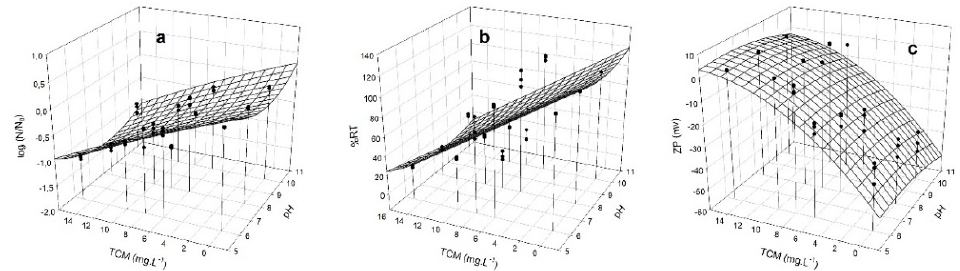
Figure 5. Response surface plot for M. aeruginosa PCC 7806 of: ( a ) log (N/N 0 ); ( b ) %RT removal; and ( c ) ZP of the clarified zone, as a function of different concentrations of TMC (mg L − 1 ) and pHs. (•) experimental measurements.